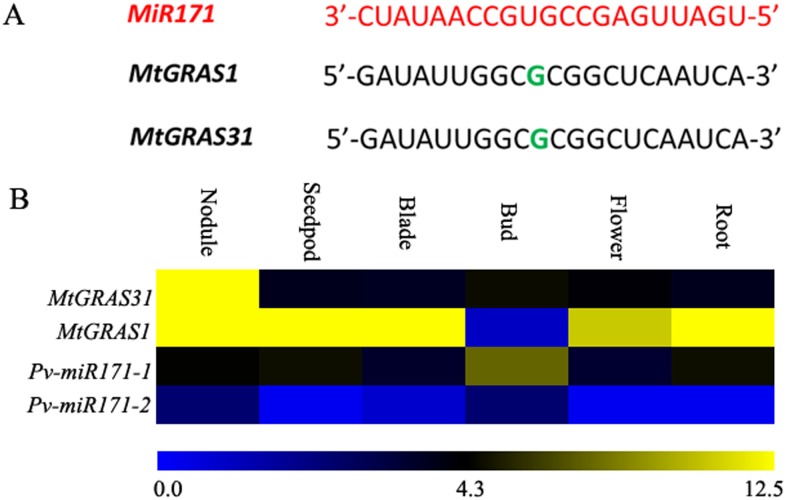
Putative Pv-miR171 genes and their target MtGRAS genes.(A) miRNA171 cleavage sites in MtGRAS genes. (B) The expression patterns of Pv-miR171 genes and their target MtGRAS genes in different tissues. Pv-miR171-1: Medtr4g111710; Pv-miR171-2: Medtr1g099290.